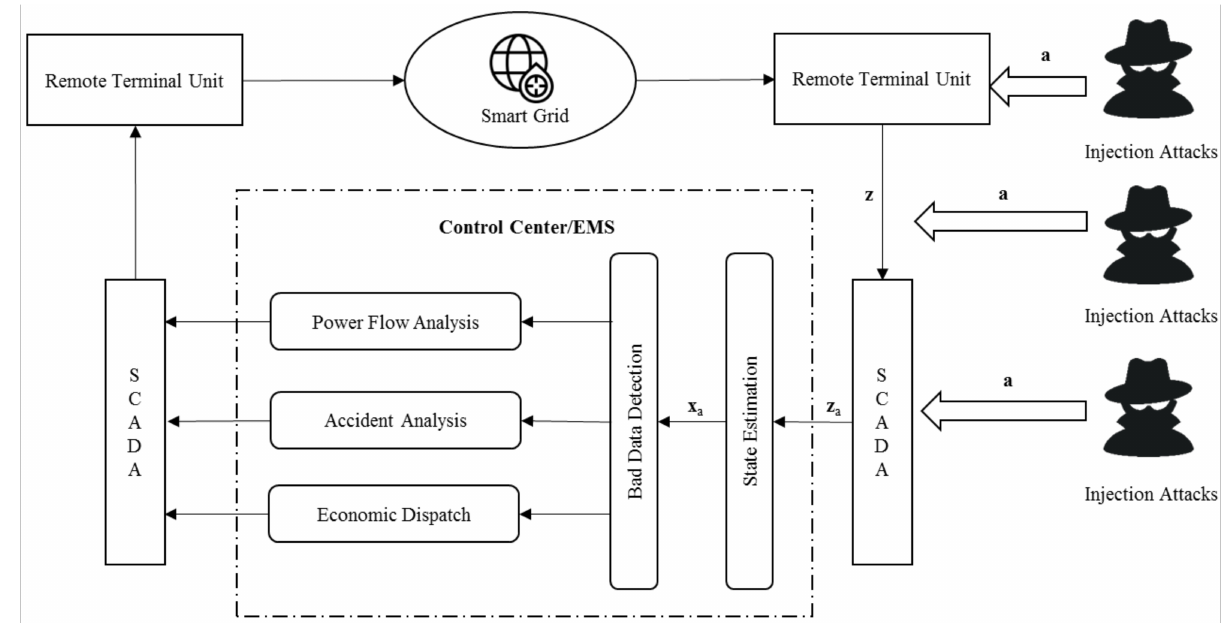
Figure 1. The state estimation under the attack.